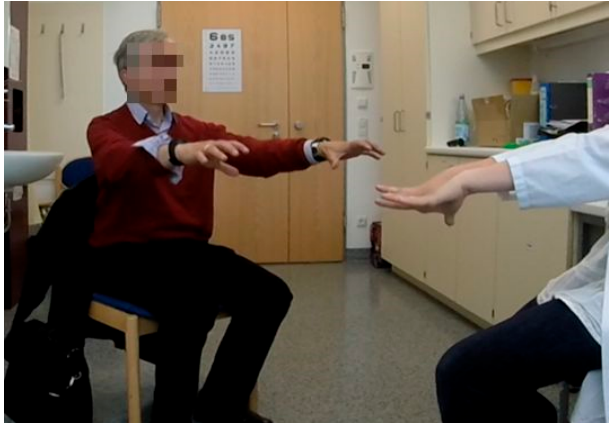
Figure 1. Standardized medical examination of upper extremity (UE) tremor.